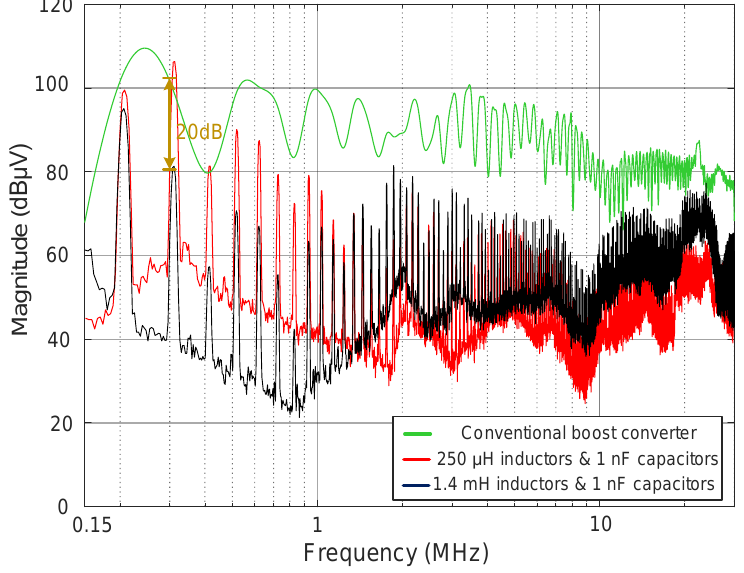
Figure 13. CM noise comparison after replacing the 250 μH inductors with 1.4 mH inductors.